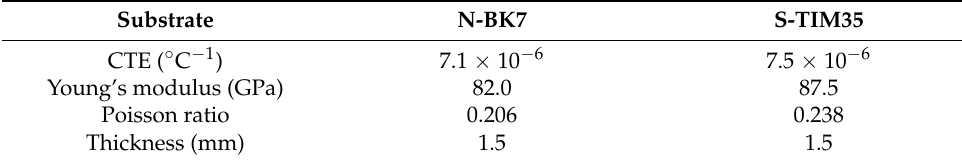
Table 1. Material properties of the different glass